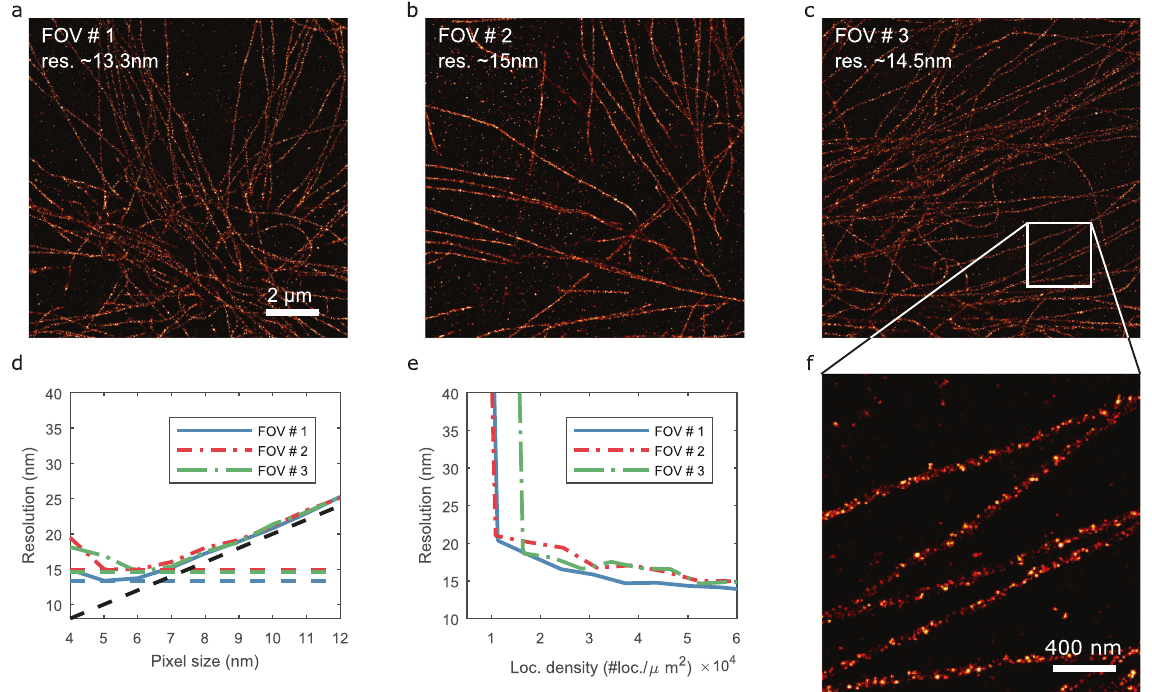
Fig. 3 Resolution estimation of DNA-PAINT data. a – c Bilinear histogram of microtubule data at 5 nm pixel size, scale bar: 2 µ m. d Resolution as a function of the pixel size. e Resolution as a function of the loc. density. f Zoom in of c , scale bar: 400